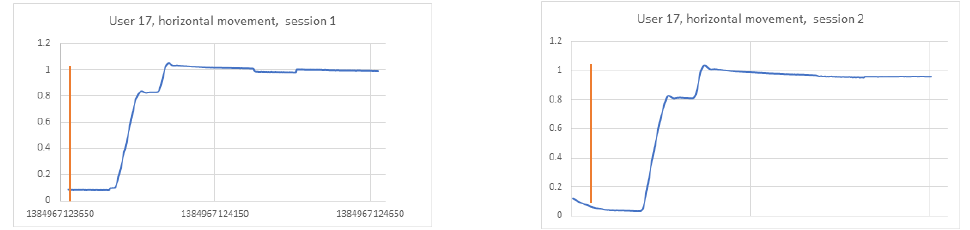
Figure 11. Horizontal signal–user 17 session 1 on the left , session 2 on the right .